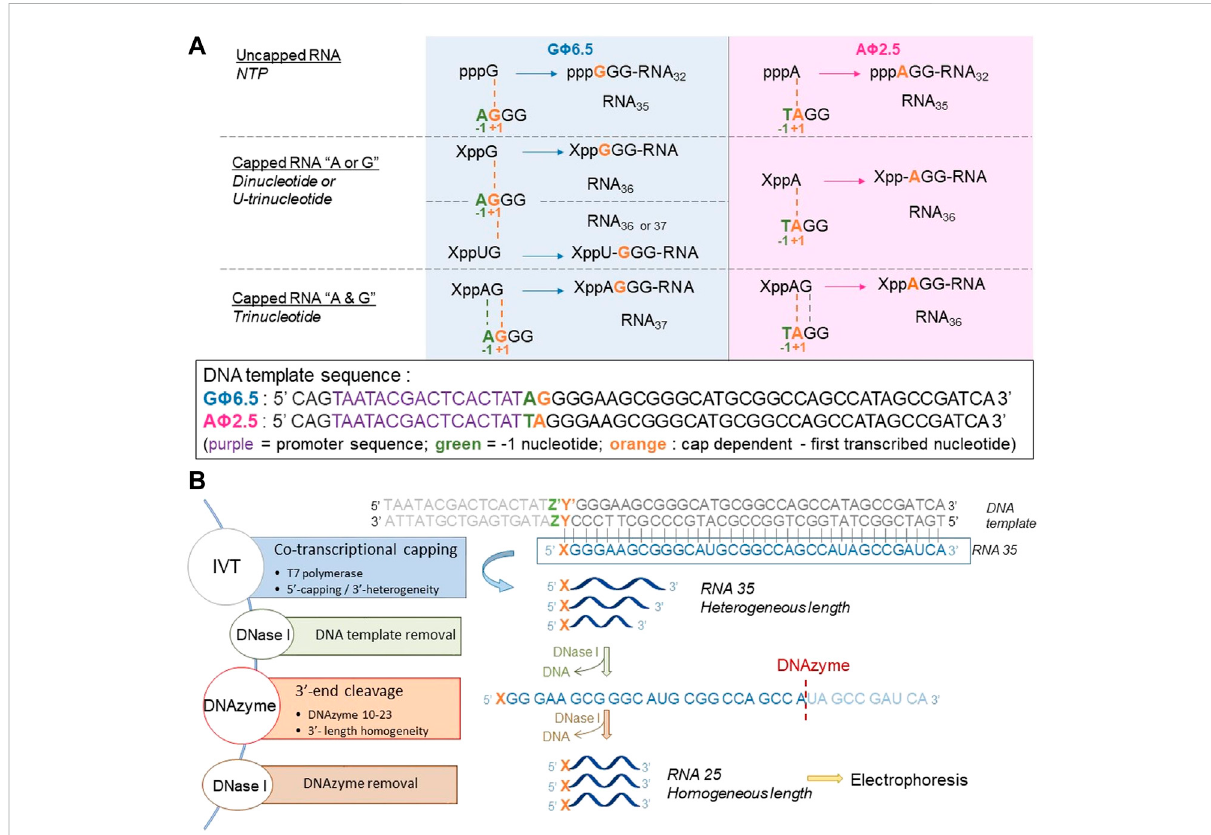
FIGURE 2 (A) Transcription initiation events expected for the φ 2.5 and φ 6.5 T7 promoters and different initiating nucleotides; For clarity, only the coding (sense) strands of thepromoter regions ofdouble-stranded DNA templates are shown. (B) General in vitro transcription protocol for theassessment of nucleotide analog incorporation.